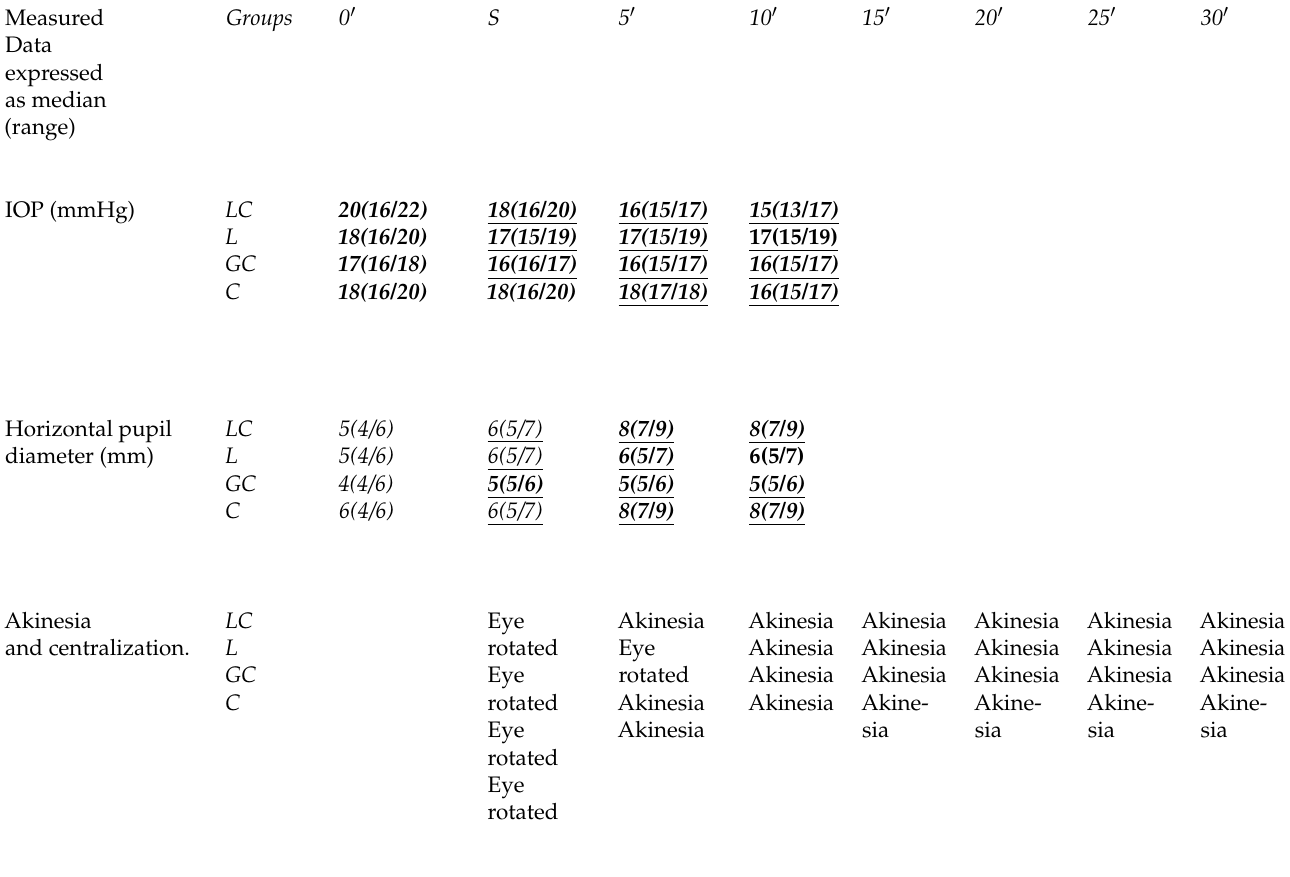
Table 1. Ophthalmic variables recorded in the groups: Legend: IOP, intraocular pressure;